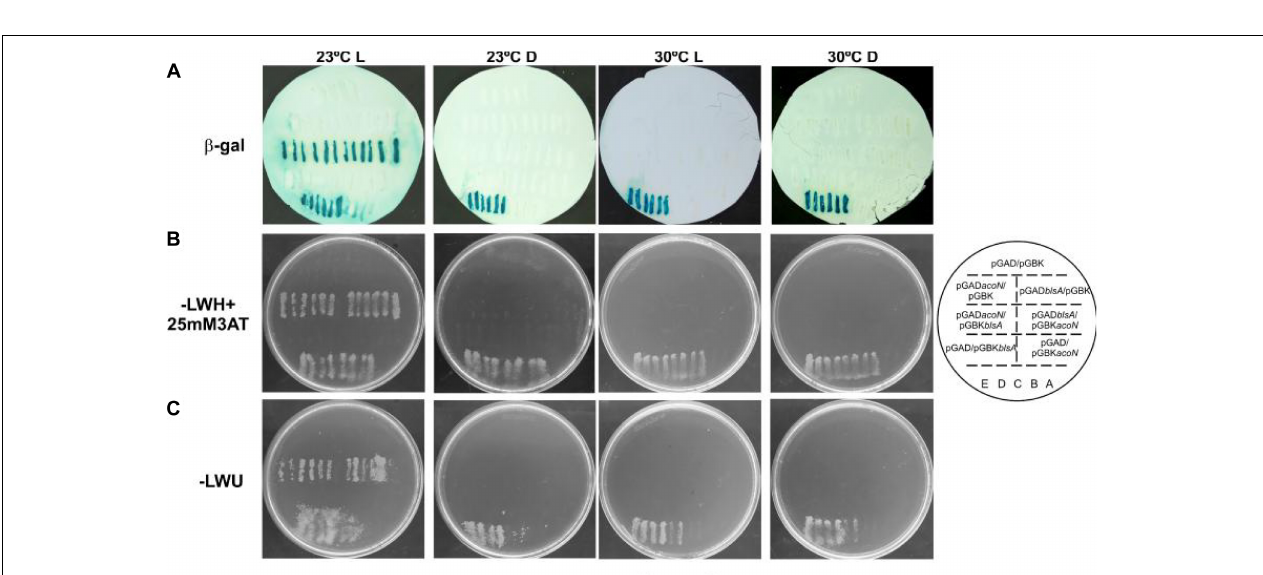
FIGURE 5 | Acetoin catabolism genes are induced under blue light at moderate temperatures. (A–C) Estimation of the expression levels of representative genes of the acetoin catabolic cluster, acoA–C, by RT-qPCR in A. baumannii ATCC 17978 wild-type as well as (cid:49) blsA and (cid:49) acoN genetic backgrounds at 23 ◦ C under blue light (L) or in the dark (D). The data shown are mean ± SD of normalized relative quantities (NRQs) calculated from transcript levels measured in samples grown in M9 minimal media supplemented with acetoin as sole carbon source under blue light or in the dark at 23 ◦ C, in at least three biological replicates. Different letters indicate significant differences as determined by ANOVA followed by Tukey’s multiple comparison test ( p < 0.01).